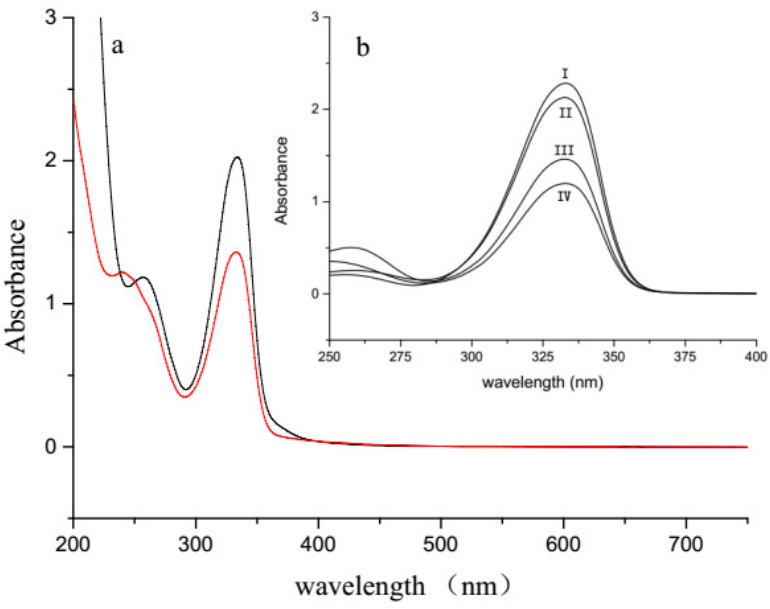
Figure 3. Full-wavelength scanning of the extraction of M. aeruginosa PCC7806 and Aph. flos-aquae CHAB5921 dry alga powder. ( a ) UV-Vis absorption spectrum of the methanolic extraction of PCC7806 (black line) and CHAB5921 (red line) strains. Both have the same absorption at 334 nm. ( b ) Collecting the two fractions of the strain PCC7806 and CHAB5921. Both showed the same ab- sorption at 334 nm. Line I: 7806-Shinorine; Line II: 5921-Shinorine; Line III: 5921-Porphyra-334; Line IV: